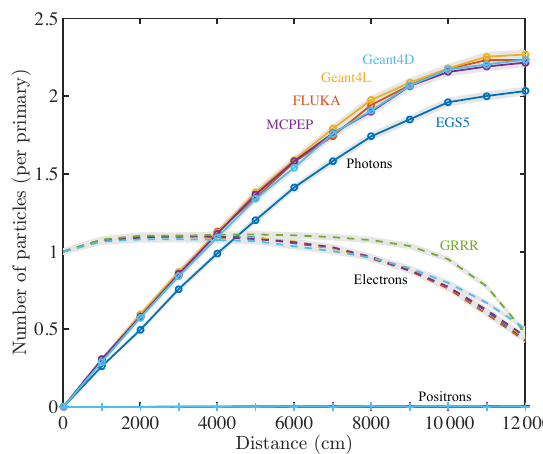
Figure 5. Products of a beam of 40MeV electrons, as detected by 12 detectors at 10 to 120m distance in 1bar and 273K. The de- tectors are impenetrable to hinder backscattering; therefore, a new simulation is run for every detector